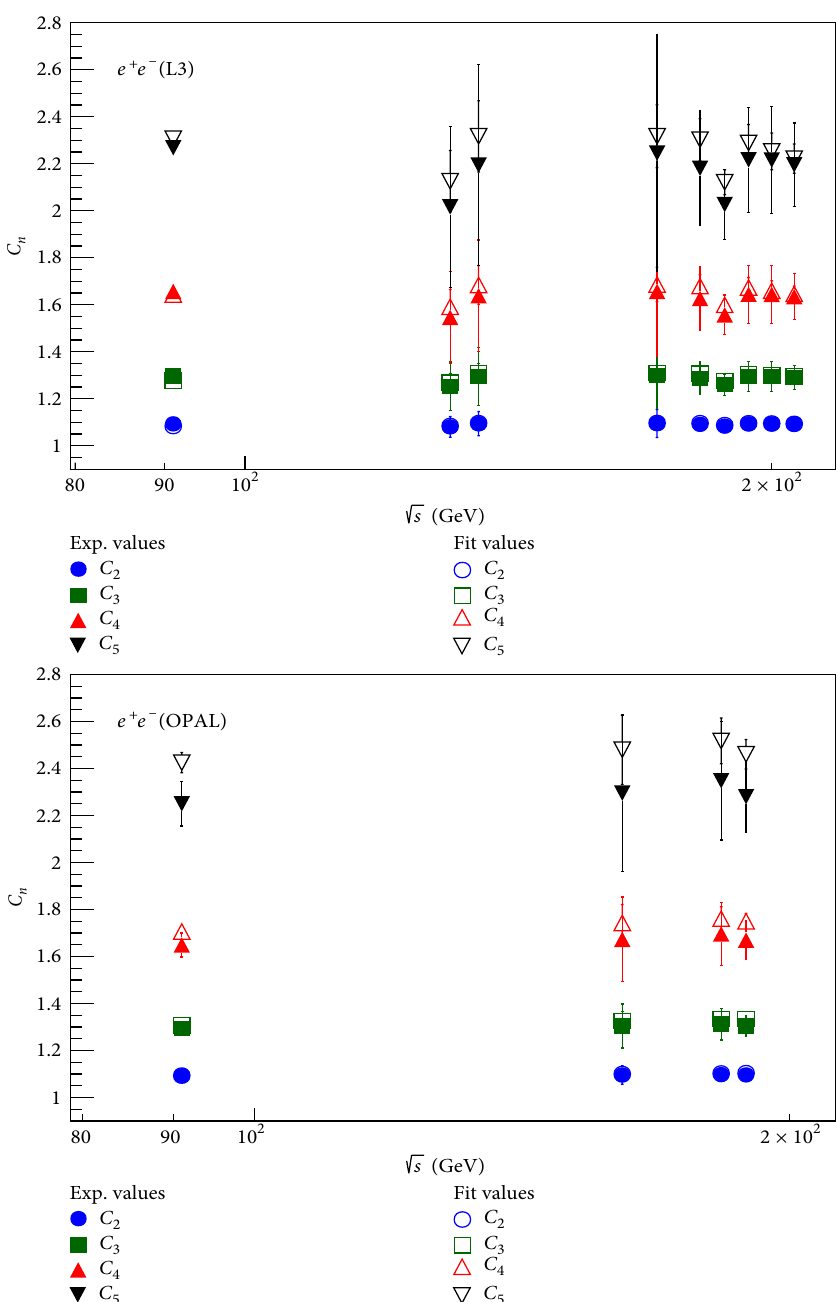
Figure 3: Normalized moments of shifted Gompertz distribution for the